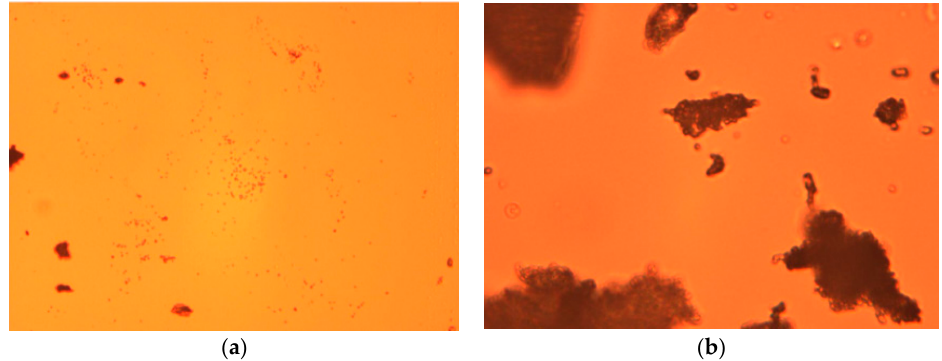
Figure 3. Butyl stearate microcapsules encapsulated in PMMA membranes.